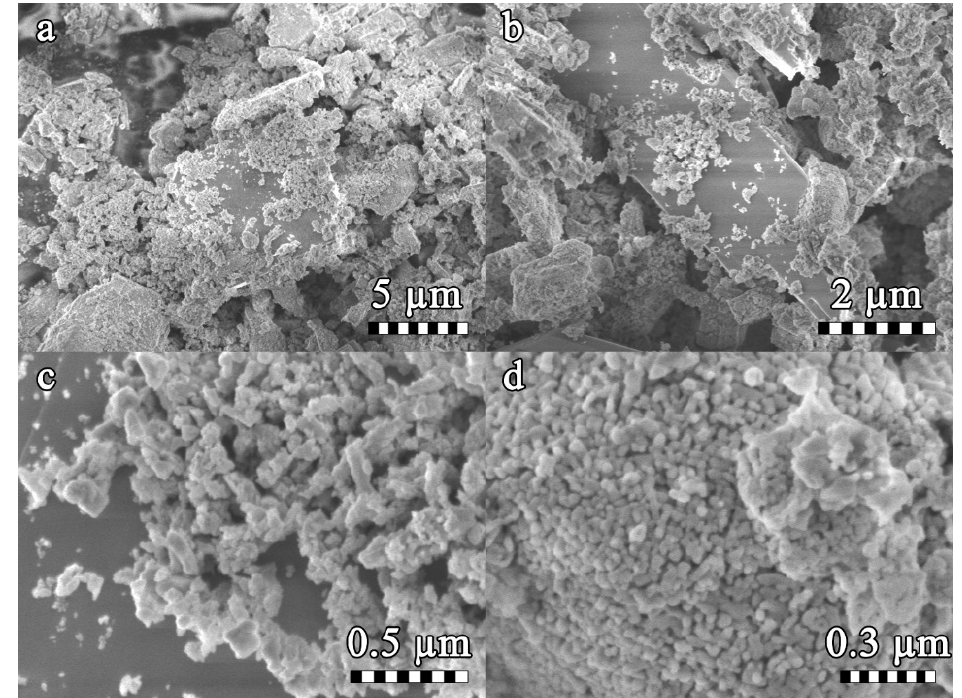
Figure 3. SEM images of sample heat-treated at 300 °C in 100 mL/min 20% N 2 /H 2 flow. Magnification: ( a ) × 7200; ( b ) × 21,000; ( c ) × 84,000; ( d ) × 117,000